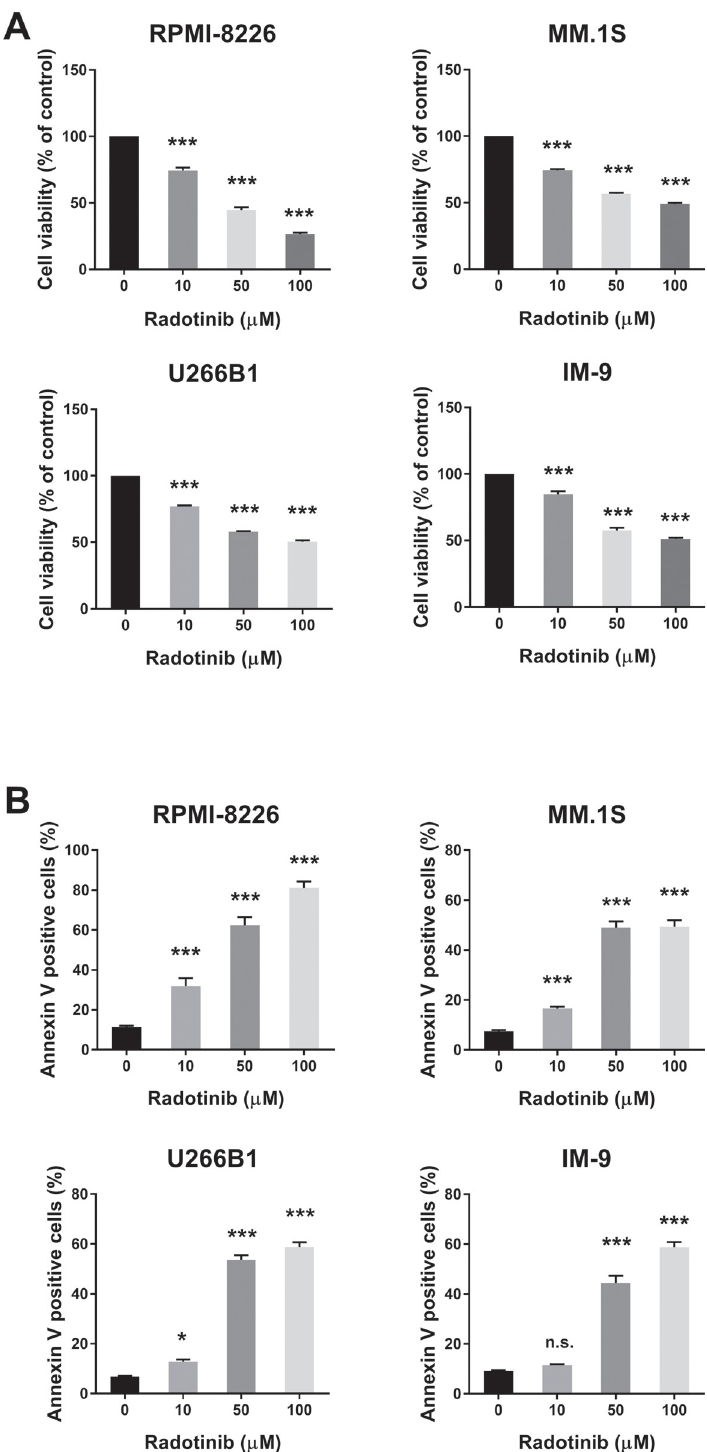
Fig 1. Radotinib induces cell death in diverse multiple myeloma cells. (A) Effects of radotinib on the viability of MM cells. Cells were incubated with 0, 10, 50, and 100 μ M radotinib for 72 h in RPMI-8226, MM.1S, U266B1, and IM- 9 cells. (B) Radotinib induces apoptosis in MM cells. The cells were also collected and treated under the same conditions described above. Cells were stained with Annexin V, followed by flow cytometry analysis. Data are presented mean ± SEM.; � , P < 0.05; and ��� , P < 0.001. � Significantly different from control cells. n.s. no significance.